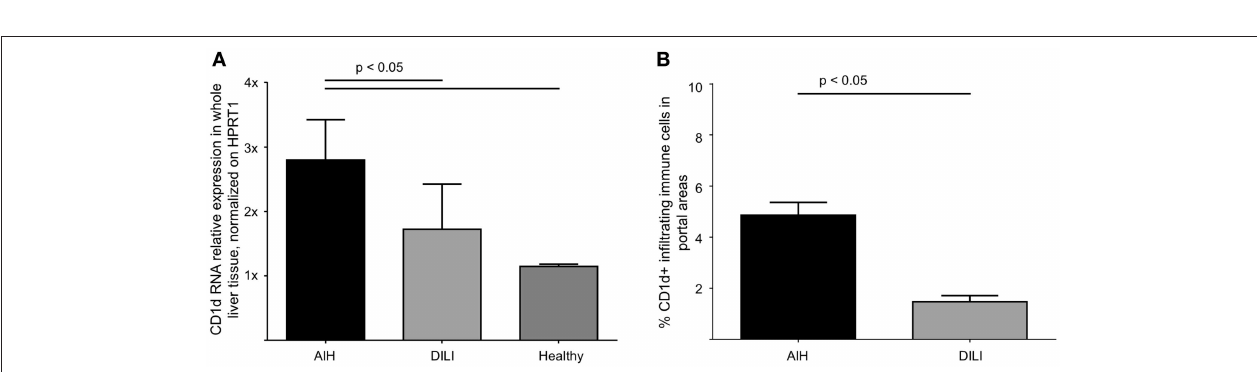
FIGURE 8 | Intrahepatic expression of CD1d is elevated in patients with autoimmune hepatitis. Quantitative PCR analysis of relative RNA expression, normalized on HPRT1, in whole liver tissue samples revealed significantly elevated levels of CD1d RNA in AIH patients in comparison to DILI patients or healthy subjects (A) . Due to CD1d-RNA in situ hybridization, the expression of CD1d-RNA was significantly elevated in infiltrating lymphocytes in portal areas of patients AIH in comparison to patients with DILI (B) .